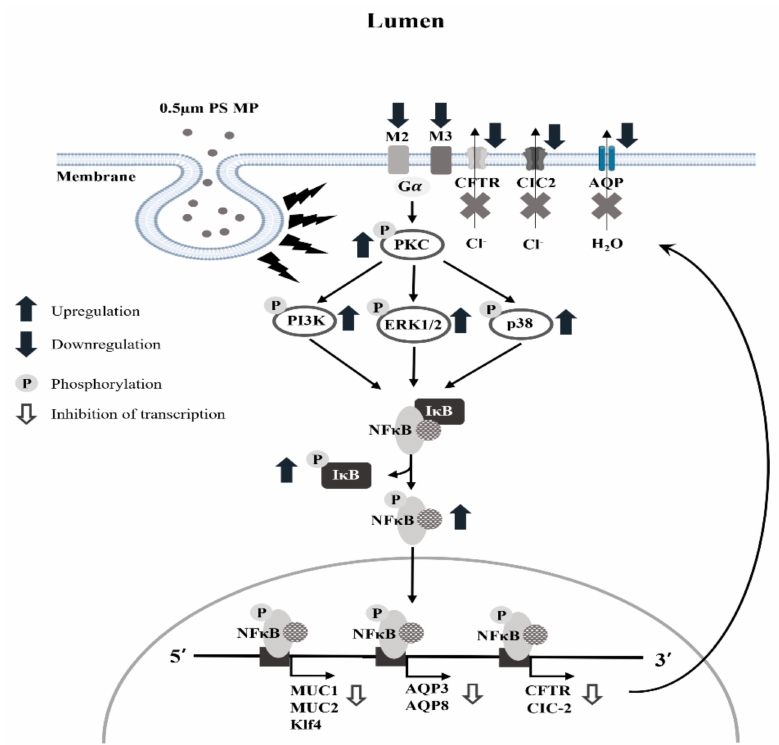
Figure 12. Suggested mechanism of MP-induced constipation in ICR mice. In this scheme, the internalization of PS-MP is thought to be affected by the mAChRs downstream signaling pathway through the regulation of PKC, MAPK and NF- κ B. Finally, the activated NF- κ B translocate into the nucleus and inhibits the expression of mucin, AQP and chloride ion channel